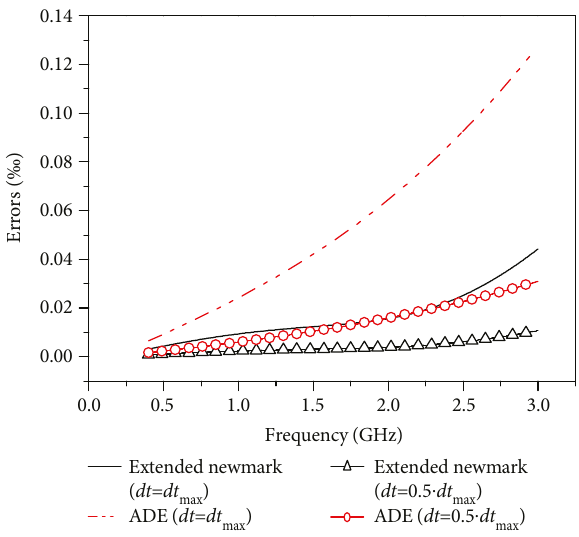
Figure 1: The relative error of ε ω and ε ω for the extended Newmark